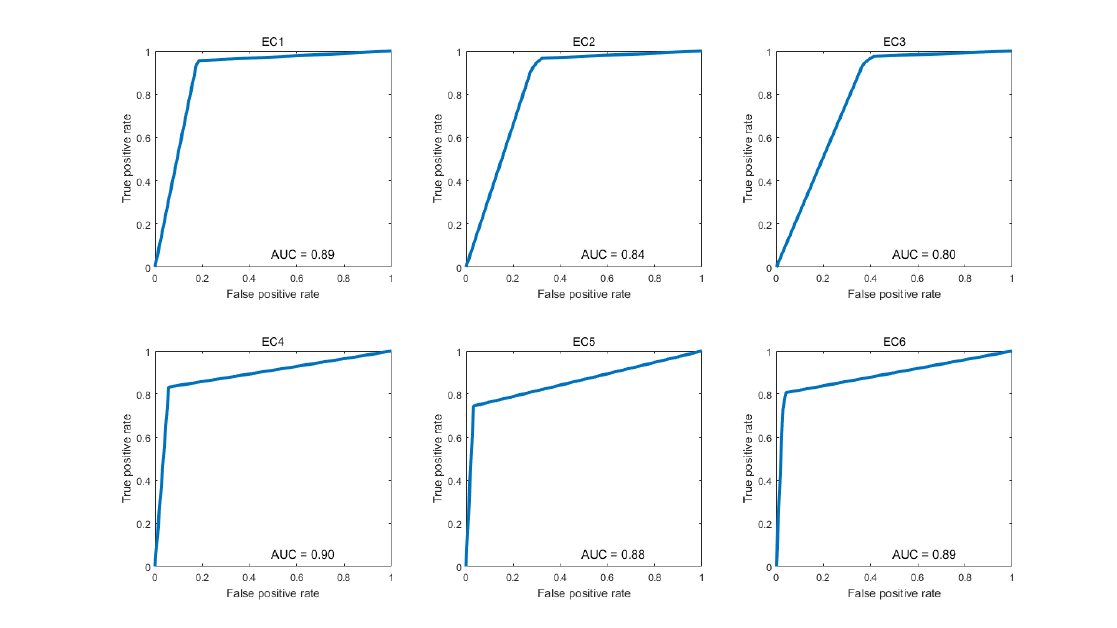
Figure 3. ROC curves for each enzymatic class for Architecture